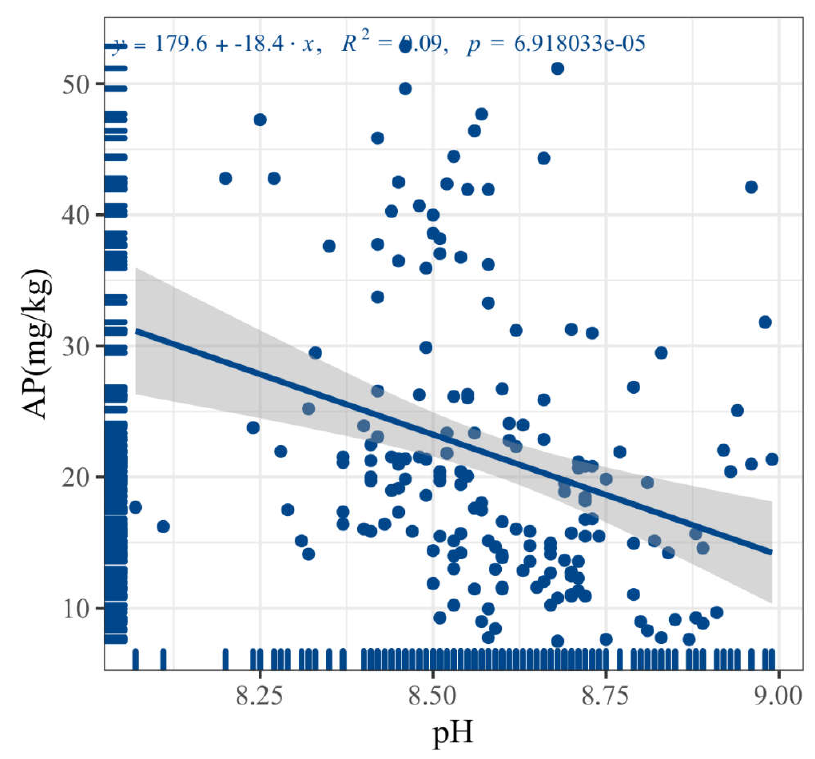
Figure 6. Scatter diagram between soil pH and soil available phosphorus.